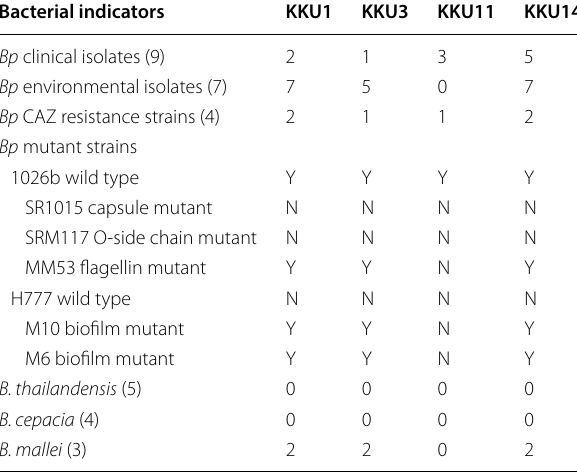
Numbers in brackets indicate number of test isolates For mutant results, they were placed under their wild type. Y sensitive, N resistant